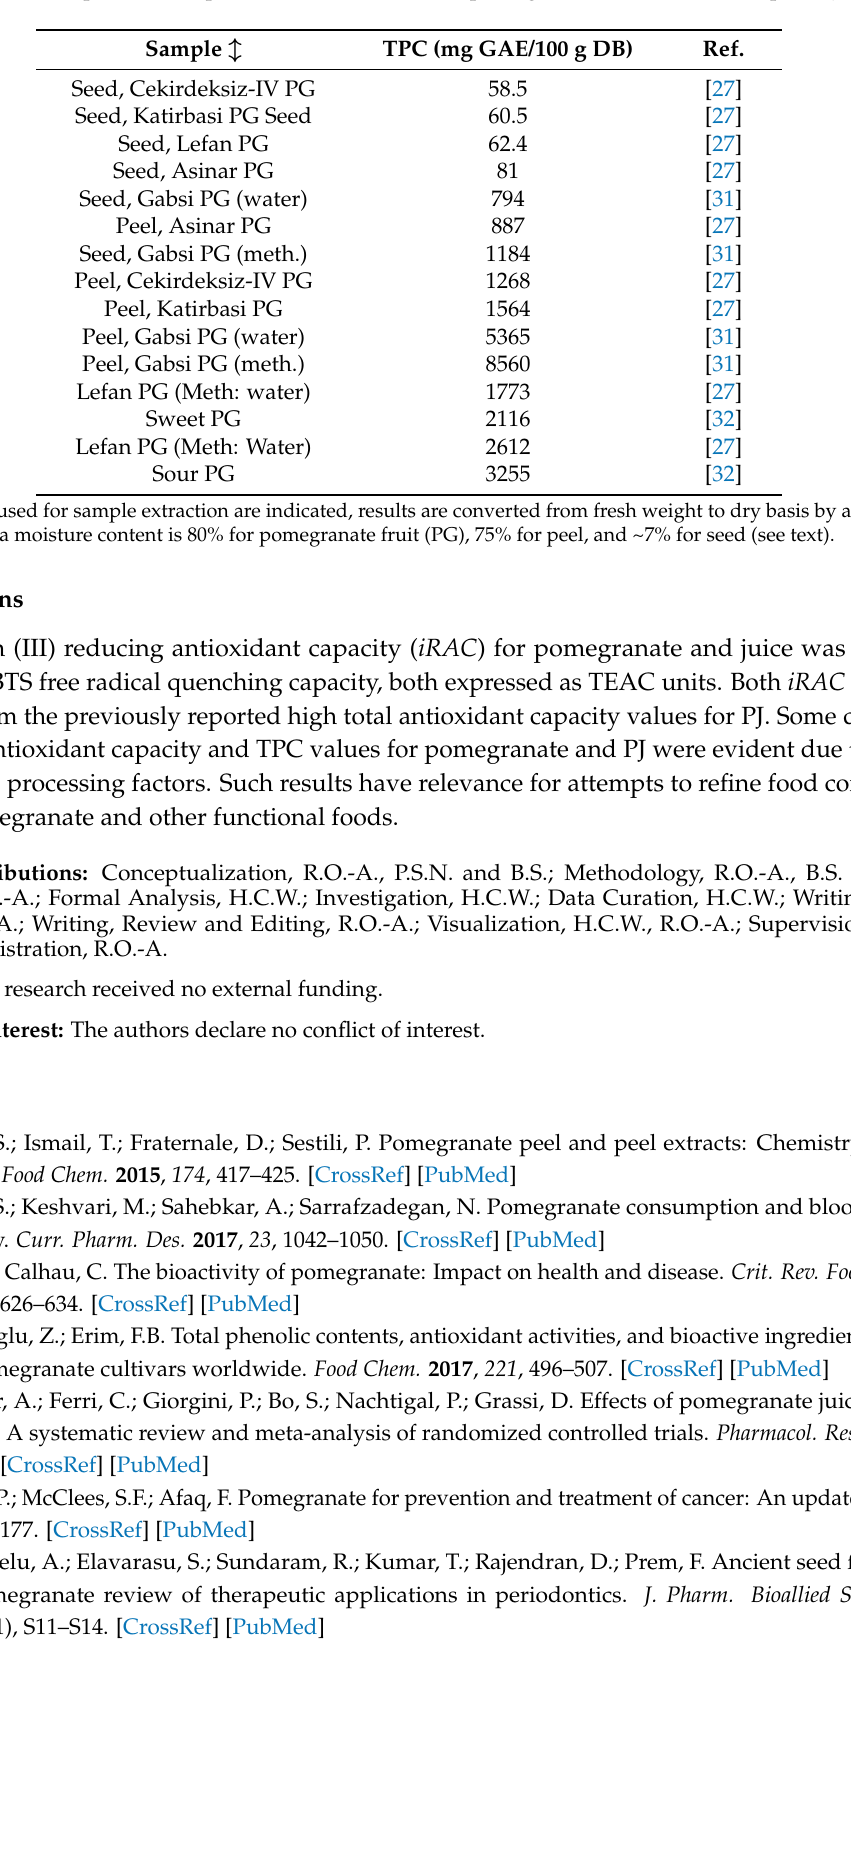
Table 4. Reported total phenols content for whole pomegranate fruit, seeds, and peels (cid:108)